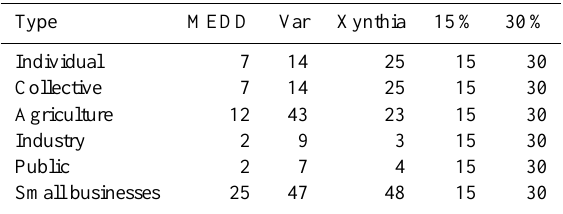
Table 1. Aggregation of capital account sectors. Table 2. Loss ratio (losses in percent of capital per unit), using three loss-ratio assumptions: the Ministry of the Environment re- port (MEDD), and the FFSA report on the Var flood (Var) and the Xynthia event